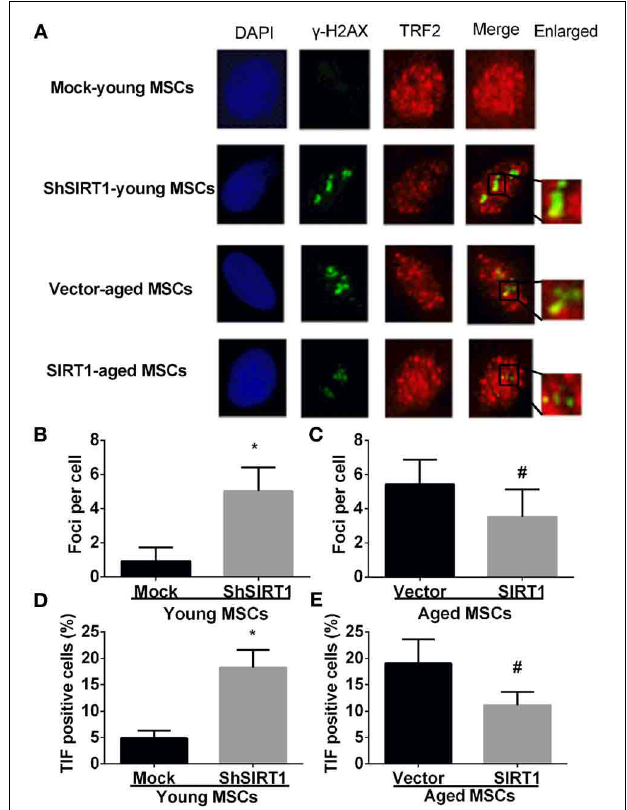
FIGURE 4 | SIRT1 protects telomere DNA damage in MSCs. Representative immunofluorescence images of young (mock- and shSIRT1-) and aged MSCs (vector- and SIRT1) stained with γ -H2AX (Green), TRF2 (Red), and DAPI (Blue) (A) . Quantitative analysis of γ -H2AX foci in young (mock- and shSIRT1-) (B) and aged MSCs (vector- and SIRT1-) (C) were shown. A cell was considered TIF positive if ≥ 50% of its γ -H2AX foci were associated with TRF2 (as shown in merged image). Quantitative analysis of TIF positive cells in young (mock- and shSIRT1-) (D) and aged MSCs (vector- and SIRT1-) (E) were shown. Data are expressed as mean ± SD (three independent experiments, n = 5 rats/group). ∗ Implies P < 0 . 05, compared to mock-young MSCs. #, P < 0 . 05, compared to vector-aged